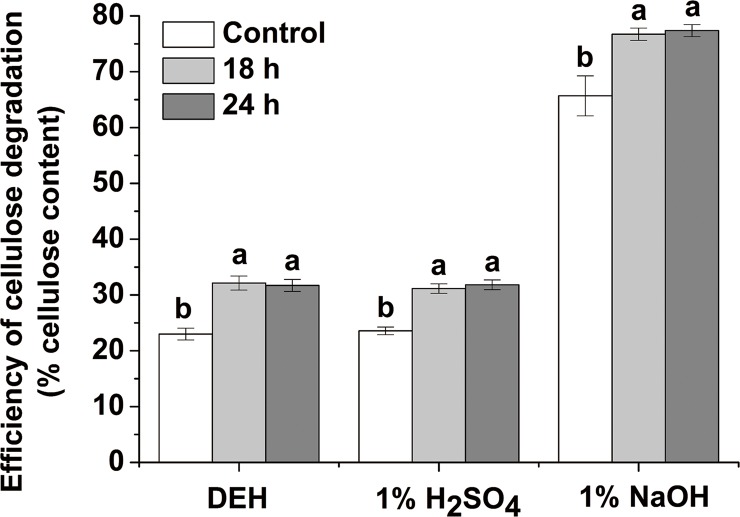
Cellulose degradation efficiency of switchgrass stem.The efficiency was calculated as the fraction of hexoses from the enzymatic hydrolysis procedure to the total cellulose in this study. The different small letters or capital letters in each group of columns indicate the significant difference at level of P < 0.05 or 0.01, respectively. The bar indicates SE (n = 5).